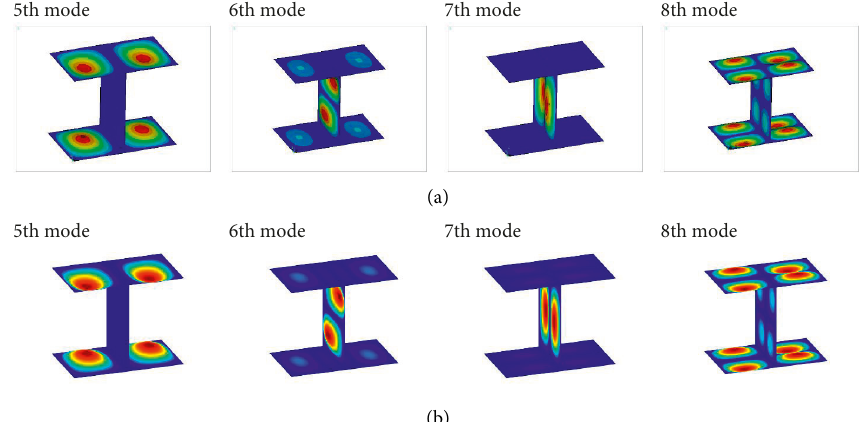
Figure 4: The 5th–8th vibration mode shapes of the stiffened panel structure in the stiffened double panel-cavity coupled system: (a) results from ANSYS and (b) results from the current